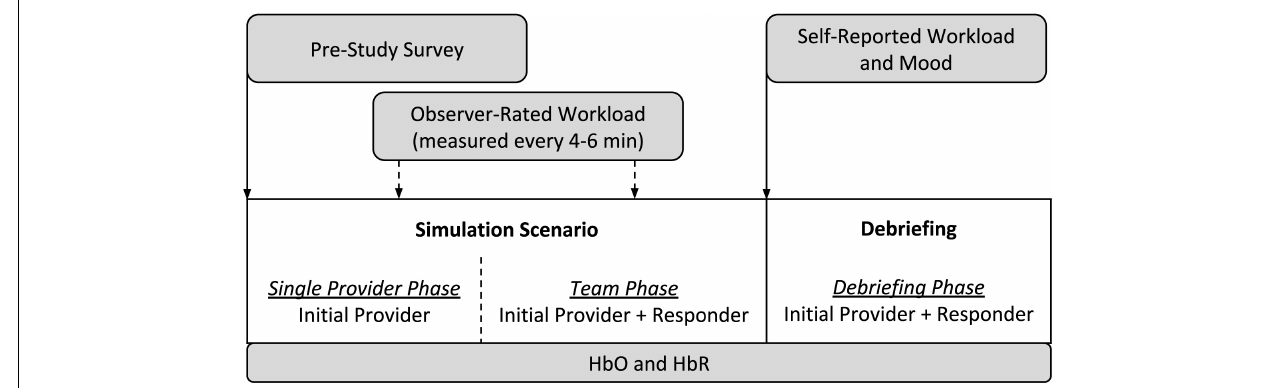
FIGURE 1 | The process of a simulation session in the current study.